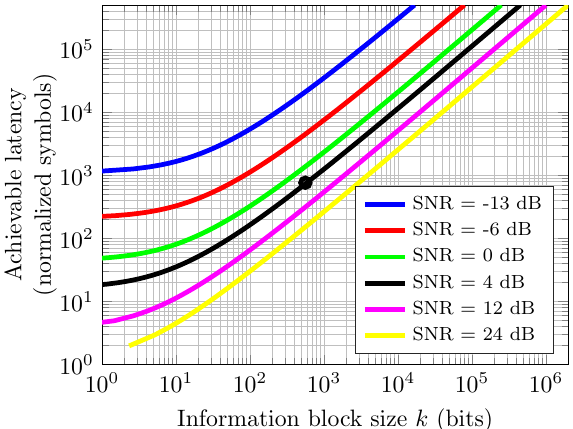
Fig. 2 Achievable latency as a function of the information block size for different channel conditions. Probability of block error ǫ = 10 − 5 . For example, at 4 dB, a message of k = 584 bits has a latency of L = 7.67 µ s (black round